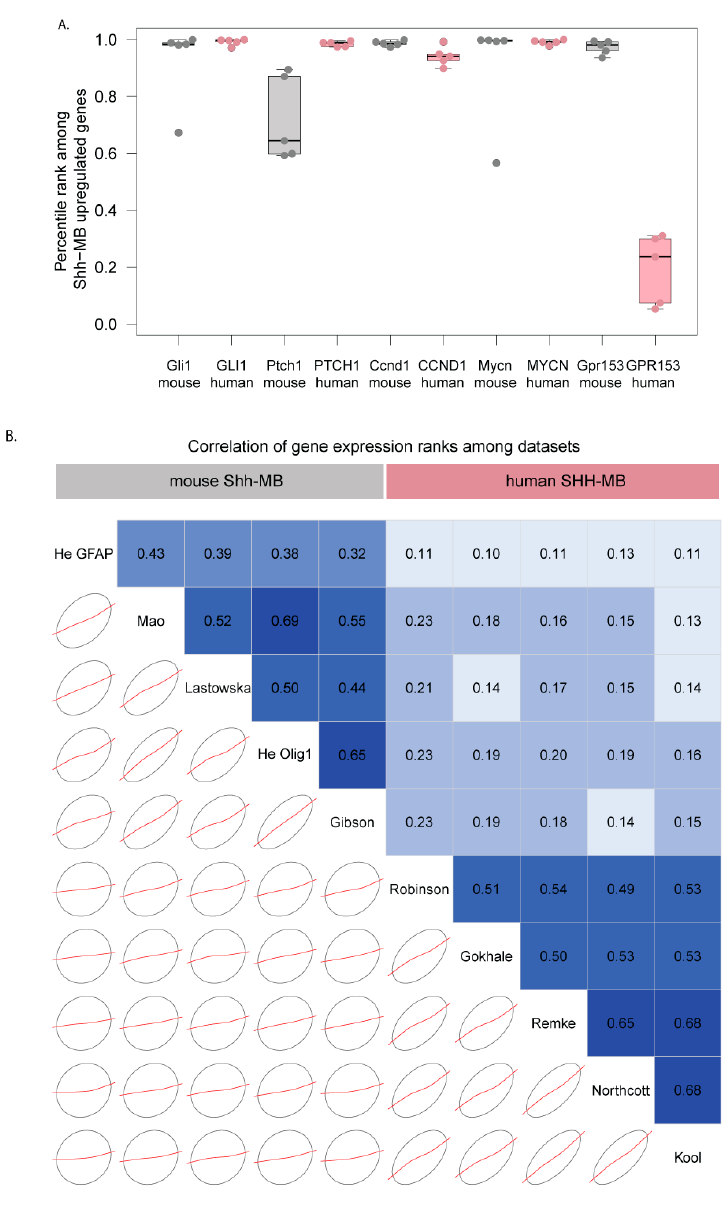
Figure 3. ( A ) GPR153 differs in expression from canonical Shh targets in human SHH-MB. Genes from multiple human (pink) and mouse (grey) Shh-MB datasets were ranked according to the degree to which they are overexpressed in Shh-MB compared to other MB groups (human) or healthy cerebellar tissue (mouse). Each point represents the quantile rank in one dataset. Boxplots show the median and interquartile range for each gene/species pair. Canonical Shh target genes Gli1/GLI1 , Ptch1/PTCH1, Ccnd1/CCND1 , and MycN/MYCN all rank highly in both mouse and human datasets, whereas Gpr153 ranks highly in all mouse datasets, but ranks in the lower half of all overexpressed genes in human SHH-MB datasets. ( B ) Gene expression patterns in Shh-MB are very similar among mouse datasets and among human datasets but show a limited correlation between human and mouse datasets. Expression data derived from microarray analysis were downloaded from GEO and reanalyzed. Correlogram [34] of median gene upregulation values in Shh-MB (see methods) between every two datasets is shown. The lower panel shows concentration ellipses and loess smoothed curves; the upper panel shows Pearson correlation coefficients in boxes shaded according to correlation coefficient values (blue-positive, red-negative).